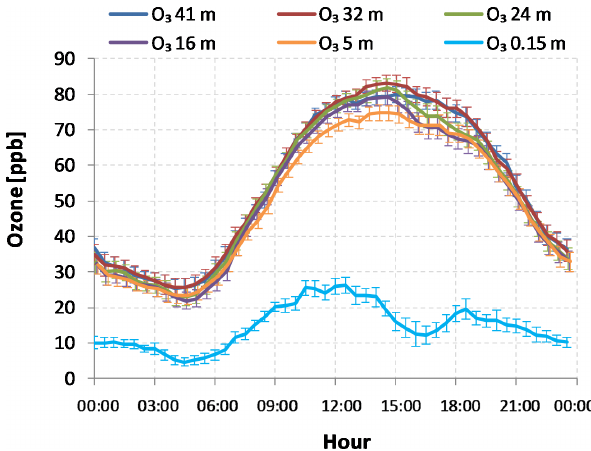
Figure 5. Average diel courses of O 3 concentrations at six levels (41, 32, 24, 16, 5 and 0.15m). Vertical bars represent the standard error of the mean.